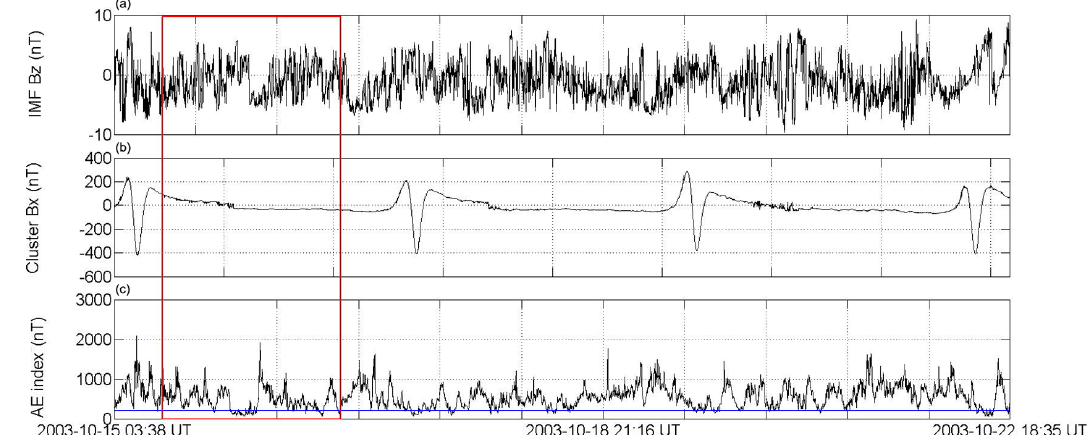
Figure 1. Time series of IMF B z (a) , Cluster B x (b) and AE index (c) for the HILDCAA event that occurred from 03:38UT on 15 October to 18:35UT on 22 October 2003.